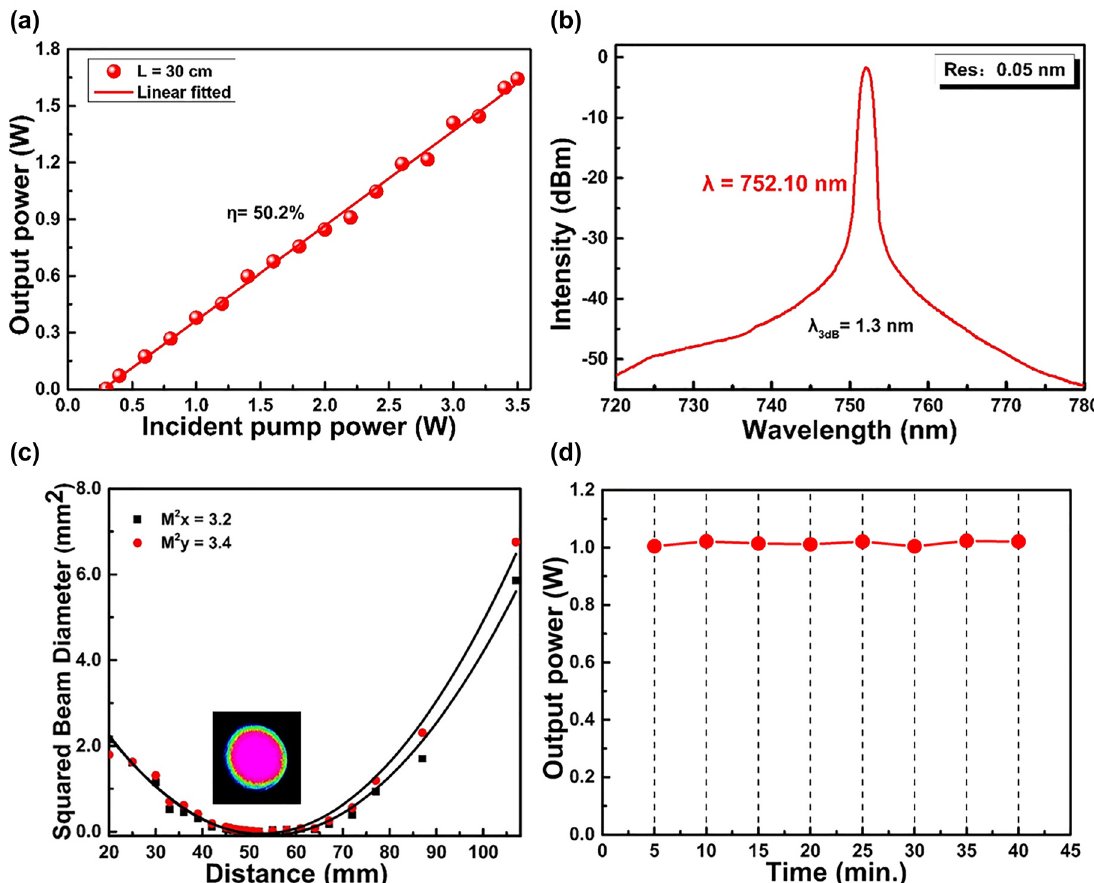
Figure 5: High performances of deep-red fiber laser with a 30 cm Ho 3 + -doped ZBLAN fi ber. (a) The output power as a function of the incident pump power. (b) The optical spectra under the maximum output power. Measured (c) beam quality M 2 and (d) power stability at ∼ 1 W of deep-red output